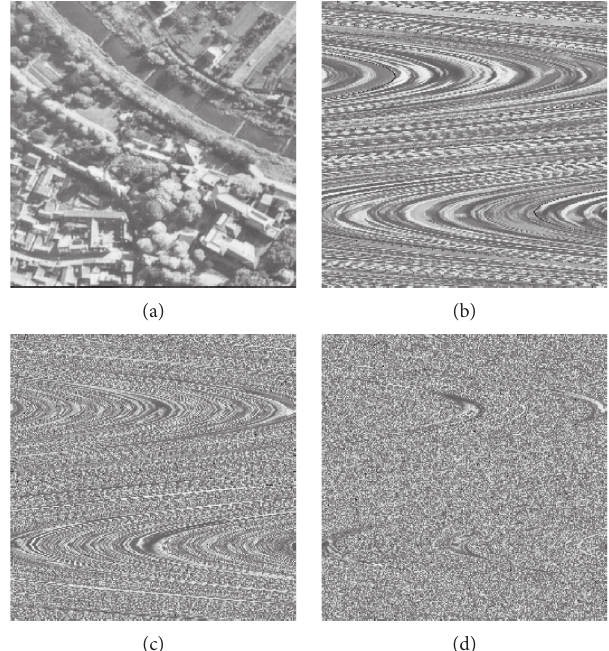
Figure 4: The discretized standard map-based permutation results: (a) the original image 5.1.10.tiff and (b, c, d) permuted results using 1 , 2 , and 3 rounds of the discretized standard